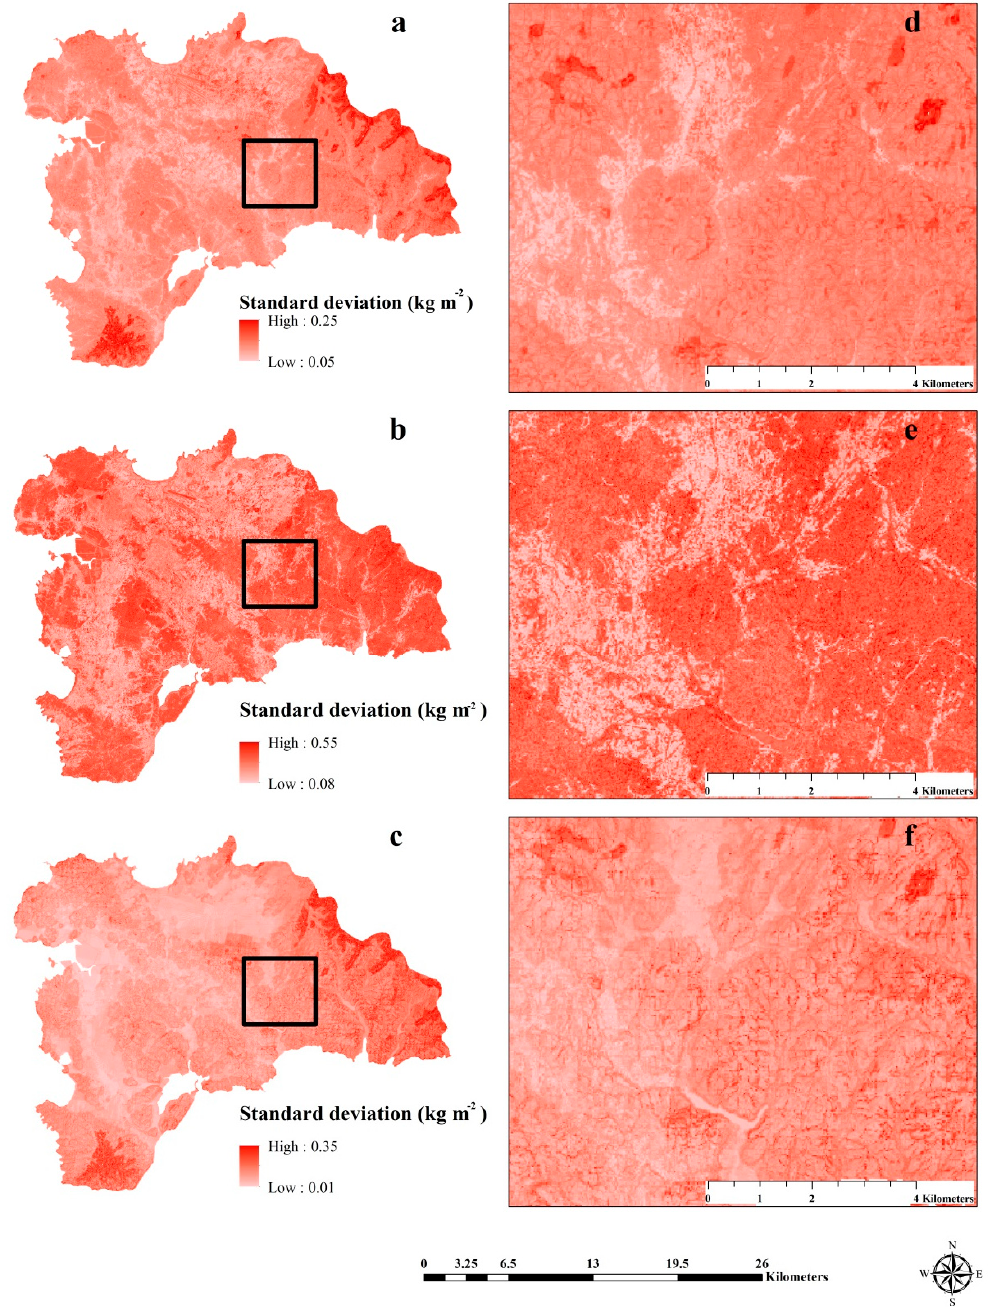
Figure 5. Standard deviation maps obtained by using three BRT models iterated 100 times. ( a ) full variables model (Model A); ( b ) topography and climate variables (Model B); and ( c ) only multispectral remote sensing variables (Model C); ( d – f ) areas covered with black boxes are detailed on the right.